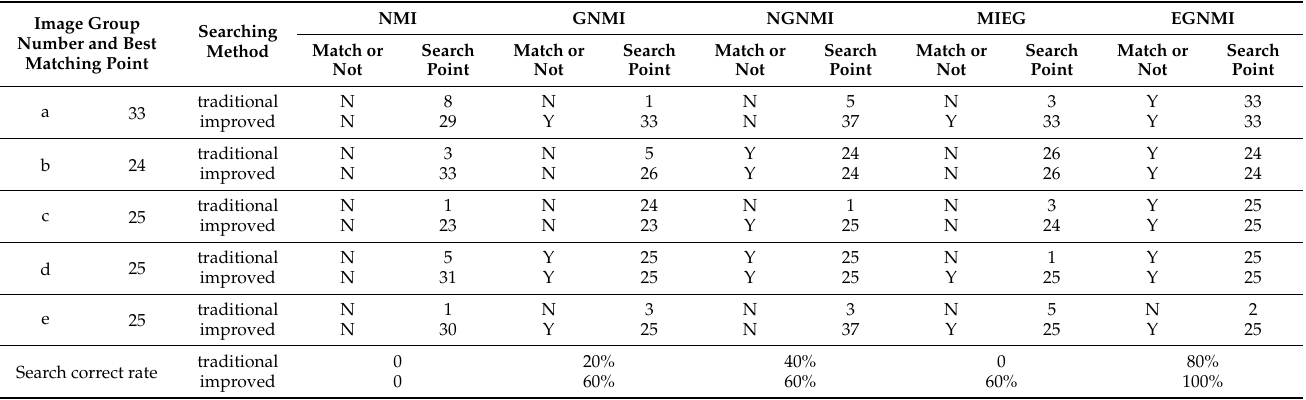
Table 3. Comparison of evaluation functions based on traditional and improved hill-climbing search